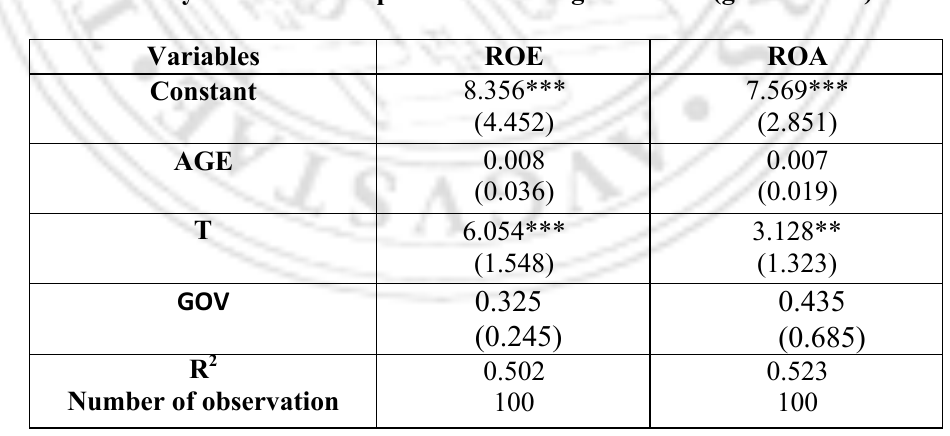
Table 3: Study of the effect of performance on governance (global